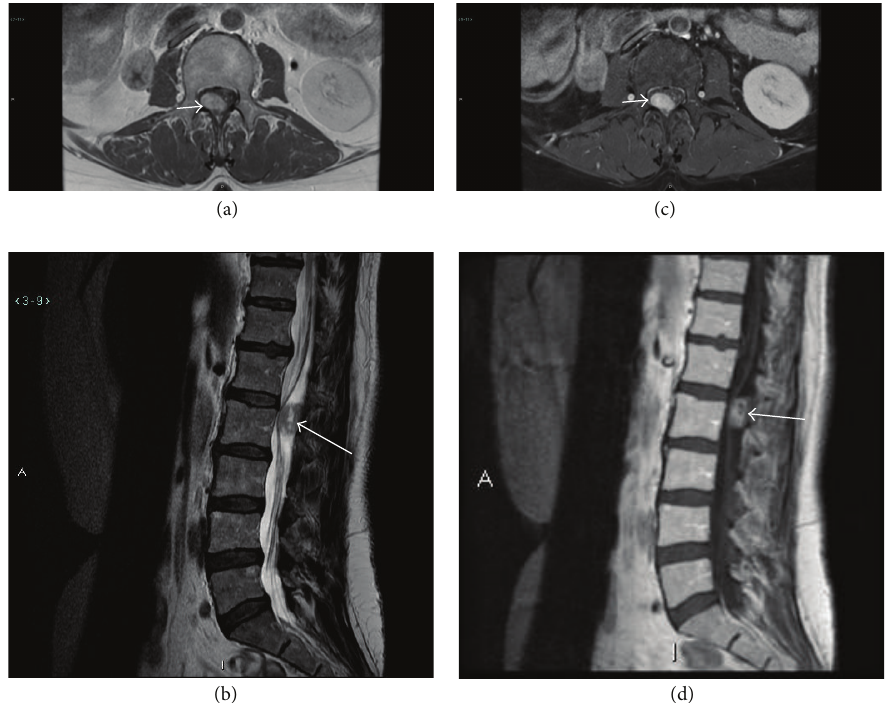
Figure 1: Axial T1 (a) and sagittal T2 (b) sequence shows a round mass (arrows) posterior to the cauda equina at L1-L2 that is hypointense on T1WI and heterogeneously hyperintense on T2WI. Axial T1 FS postcontrast (c) and sagittal T1 postcontrast (d) sequence shows an enhancing intradural, extramedullary mass (arrows) posterior to the cauda equina at L1-L2.